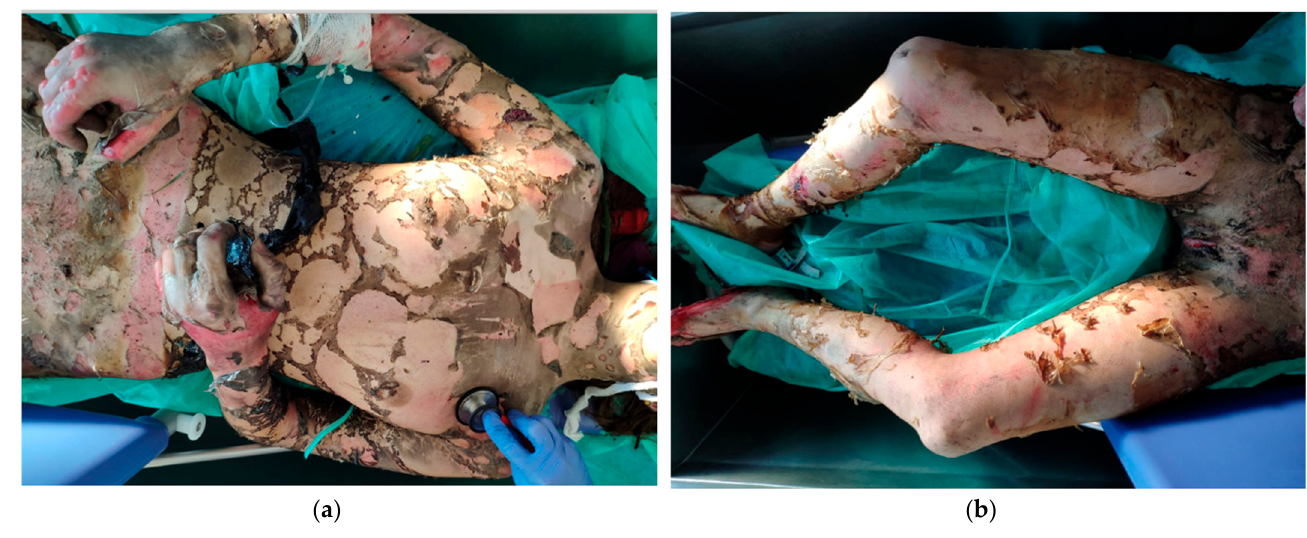
Figure 3. ( a , b ) 3rd/4th degree burns—suicide by arson.